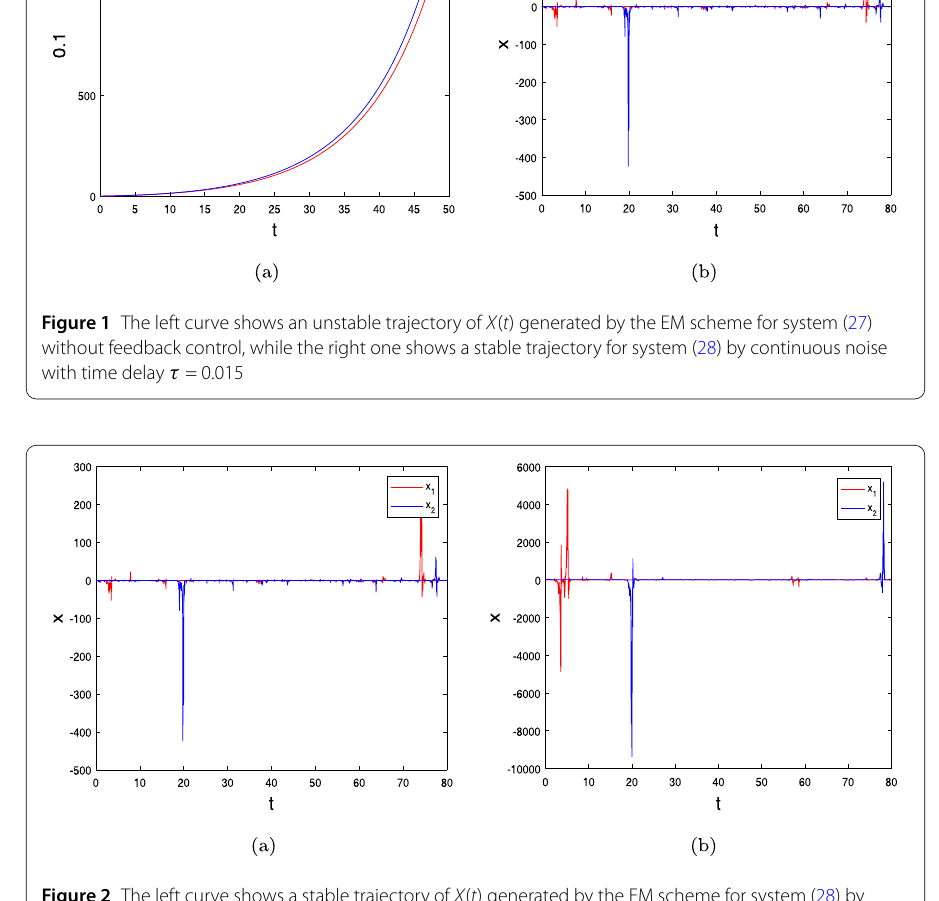
Figure 2 The left curve shows a stable trajectory of X ( t ) generated by the EM scheme for system (28) by continuous noise with time delay τ = 0.03, while the right one shows a stable trajectory for system (28) by continuous noise with time delay τ = 0.06. We can see that there is a slight difference between them